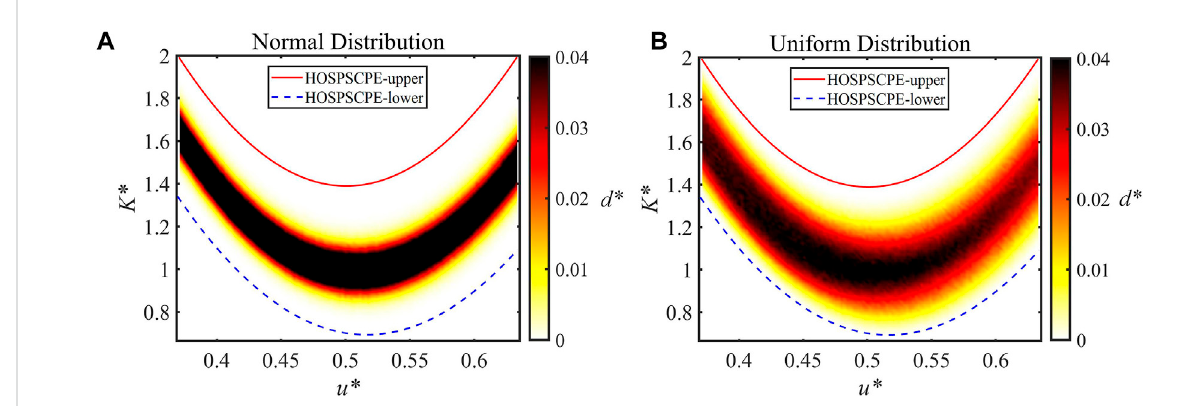
FIGURE 4 Theprobabilitydensitiesof (A) thenormaldistributionsamplesand (B) theuniformlydistributedsamplesoftheQZSmicrostructureinthequasi- zero region.